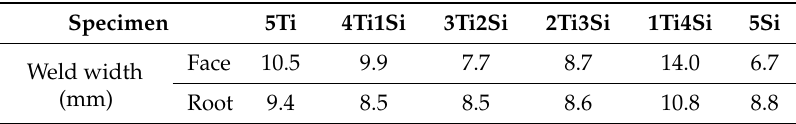
Figure 3. Macro ‐ sections of specimens welded with various types of flux.